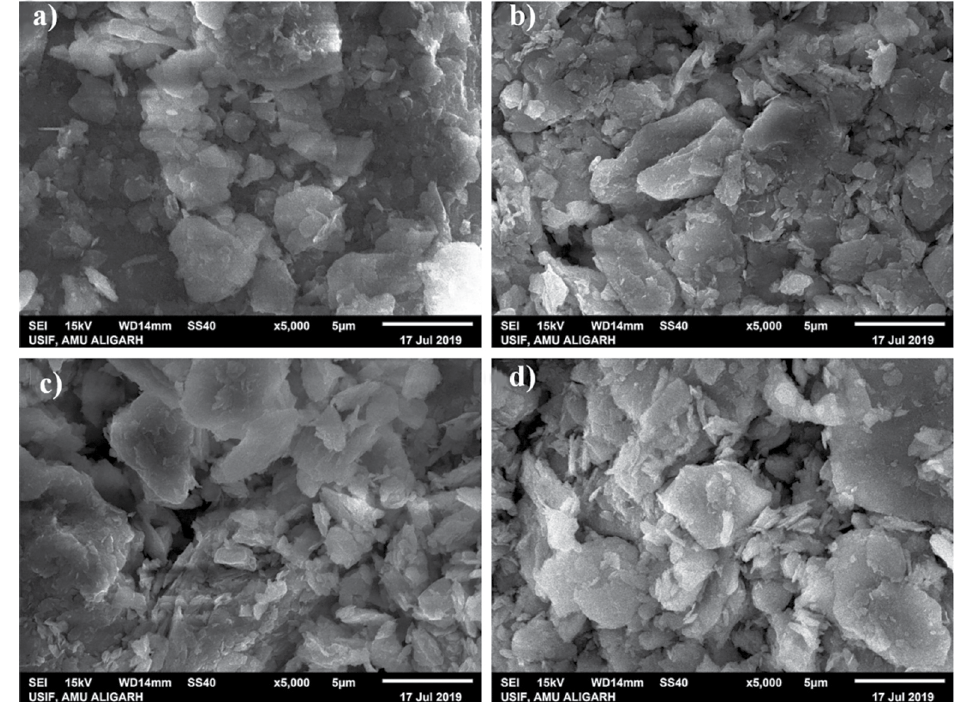
Figure 6. SEM images of: a – S0; b – S1; c – S3; d – S5